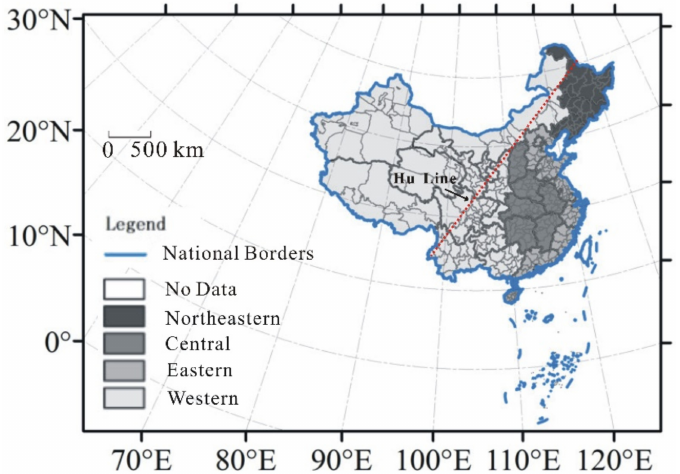
Figure 1. The administrative divisions in Chinese Mainland. Notes: Northeastern Chinese Mainland includes Heilongjiang, Jilin, and Liaoning Province; Eastern Chinese Mainland includes Hebei, Beijing, Tianjin, Shandong, Jiangsu, Shanghai, Zhejiang, Fujian, Guangdong, and Hainan Province; Central Chinese Mainland consists of Shanxi, Henan, Anhui, Hubei, Hunan, and Jiangxi Province; Western Chinese Mainland include Inner Mongolia, Gansu, Ningxia, Shaanxi, Xinjiang, Qinghai, Tibet, Sichuan, Chongqing, Guizhou, Yunnan, and Guangxi Province.